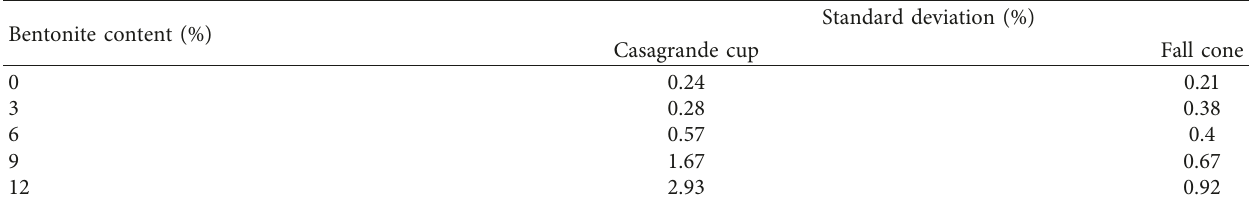
Table 3: Summary of the standard deviation of the liquid limit test results determined using the two tests.